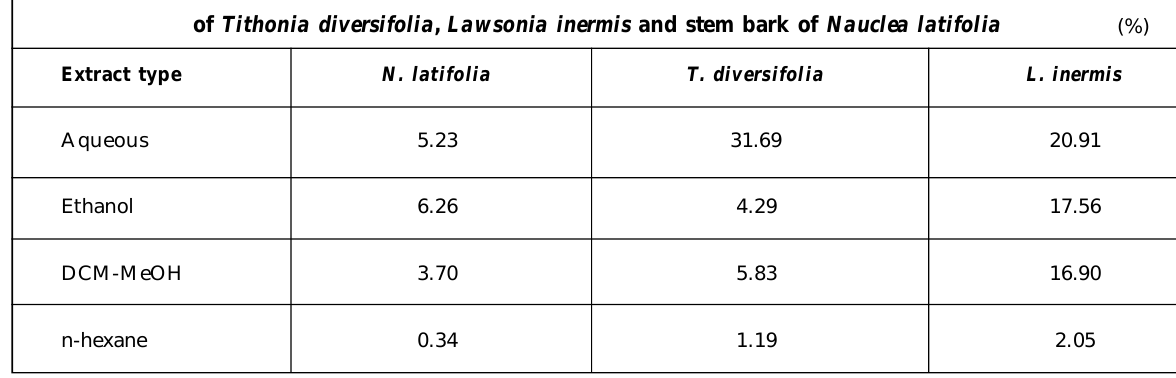
Table 1: Percentage yields of the different extracts of leaves of Tithonia diversifolia , Lawsonia inermis and stem bark of Nauclea latifolia Extract